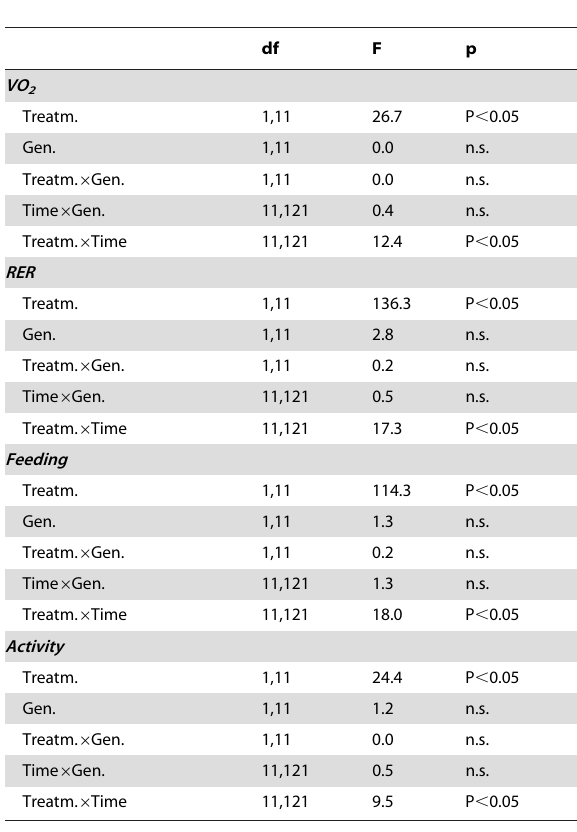
Table 3. The effects of C75 on oxygen uptake (VO 2 ), respiratory exchange ratio (RER), feeding and activity: statistical results.